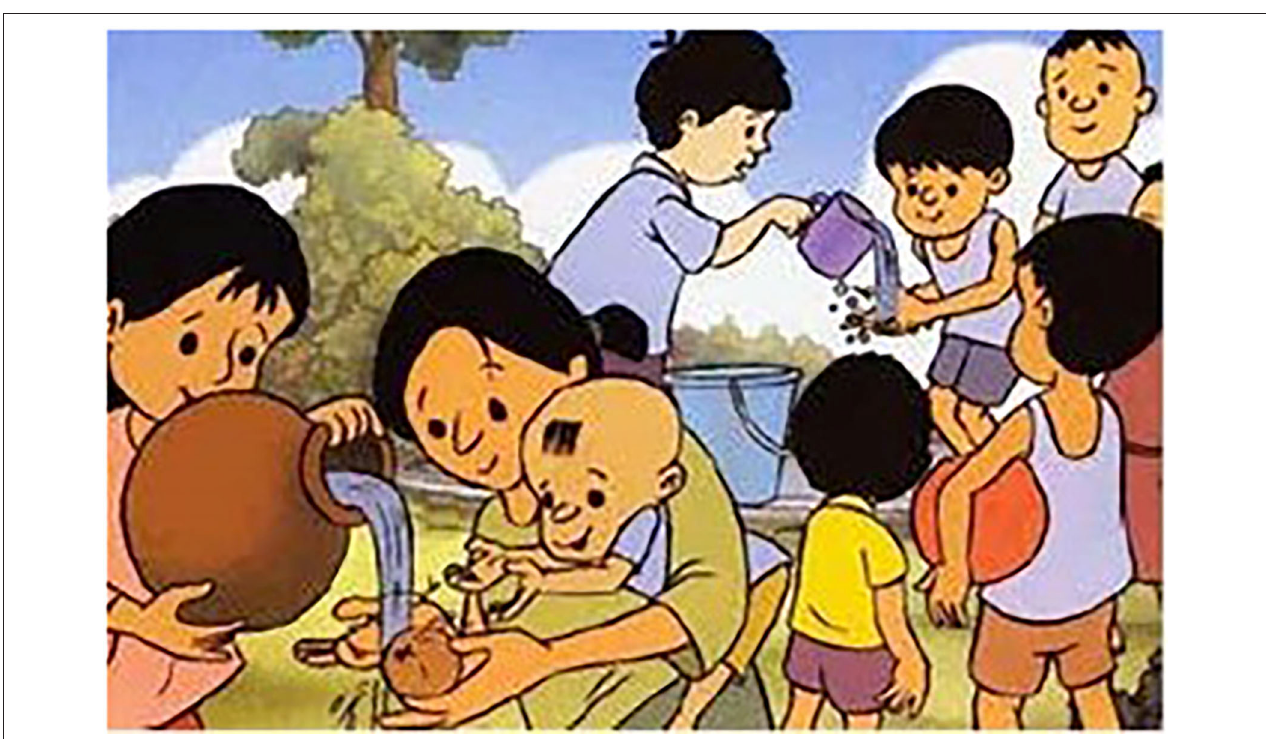
FIGURE 1 | Still from Meena episode “Health in your Hands”